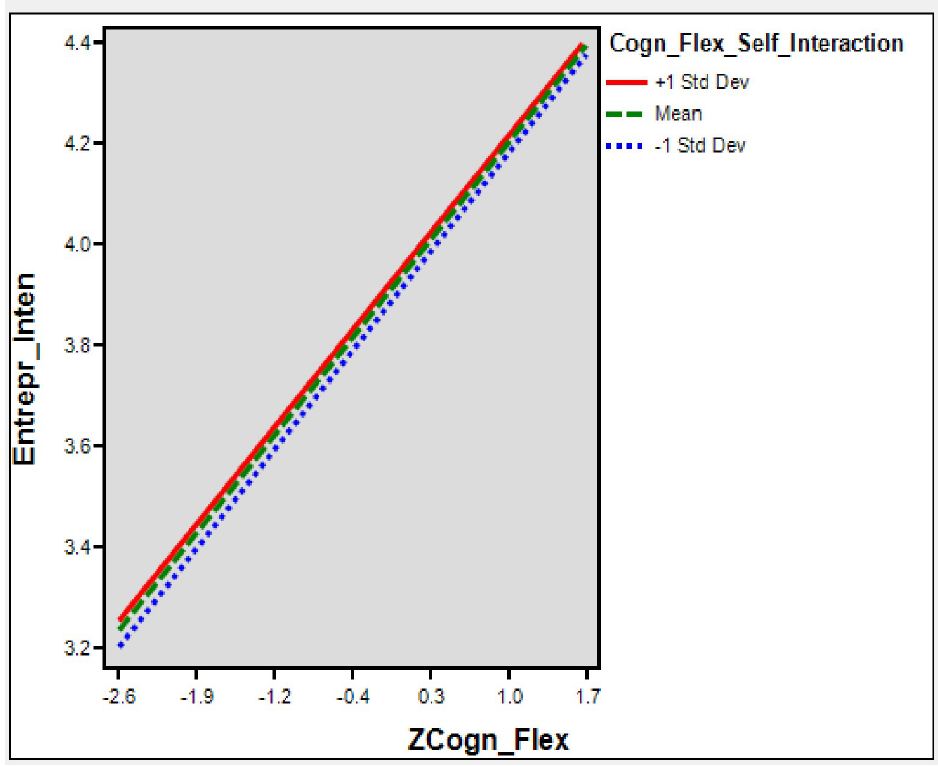
Fig 5. Interaction ESE-CF and